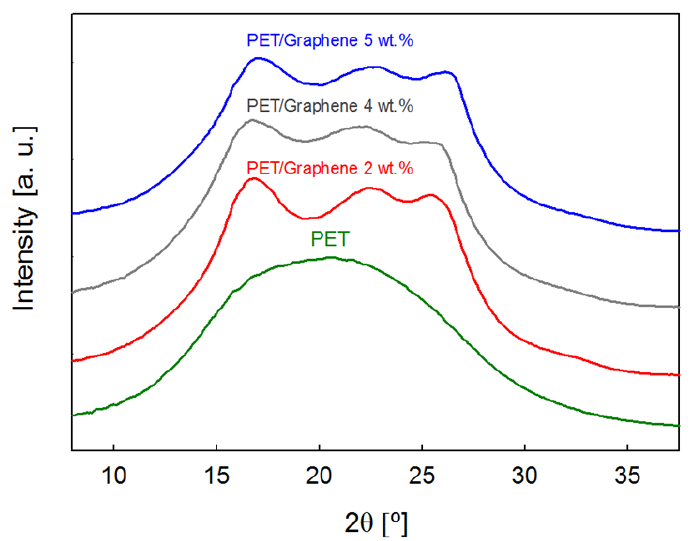
Figure 7. Scattered intensity as a function of diffraction angle for pristine PET and PET/graphene fibers with different filler content. Curves are shifted for the sake of clarity.